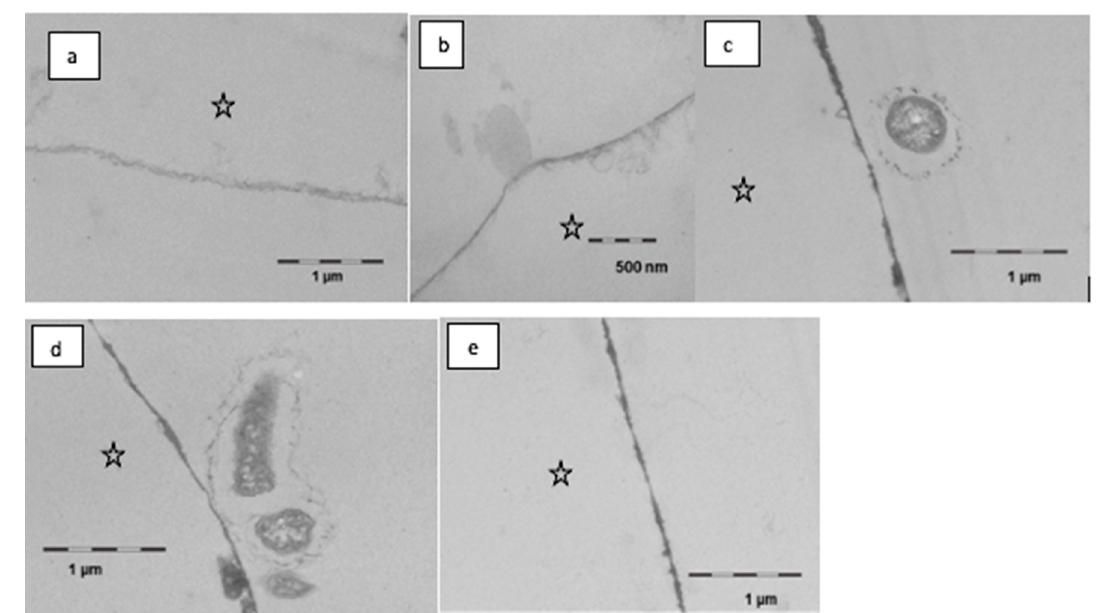
Figure 7. Transmission electron microscopy, in situ application of linseed oil for 10 min after 1 min of pellicle formation. Rinsing with the oil leads to a slight dissolution and thinning of the pellicle, partially the surface is smoother than in controls ( a , b ). Oil droplets were observed seldomly ( b ). In part, there was an optimized wetting of the surface in the sense of a subsurface pellicle. During further oral exposure for up to 120 min, a modified ultrastructure was still visible (c– e ). The basal pellicle is thicker and more electron dense, sometimes pores in the enamel are filled with proteinaceous structures. Furthermore, first adherent bacteria were detectable; the cell wall of the bacteria is damaged ( c , d ). The enamel was removed during the preparation of the samples; the former enamel side is marked with an asterisk.